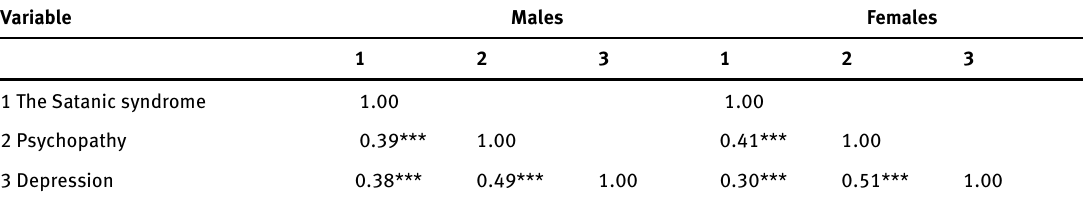
Table 4. Correlations among the Satanic syndrome, psychopathy, and depression within different sex